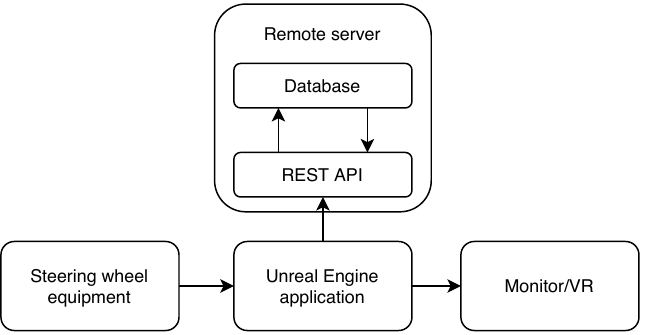
Figure 6. The architecture of the remote database connected with the